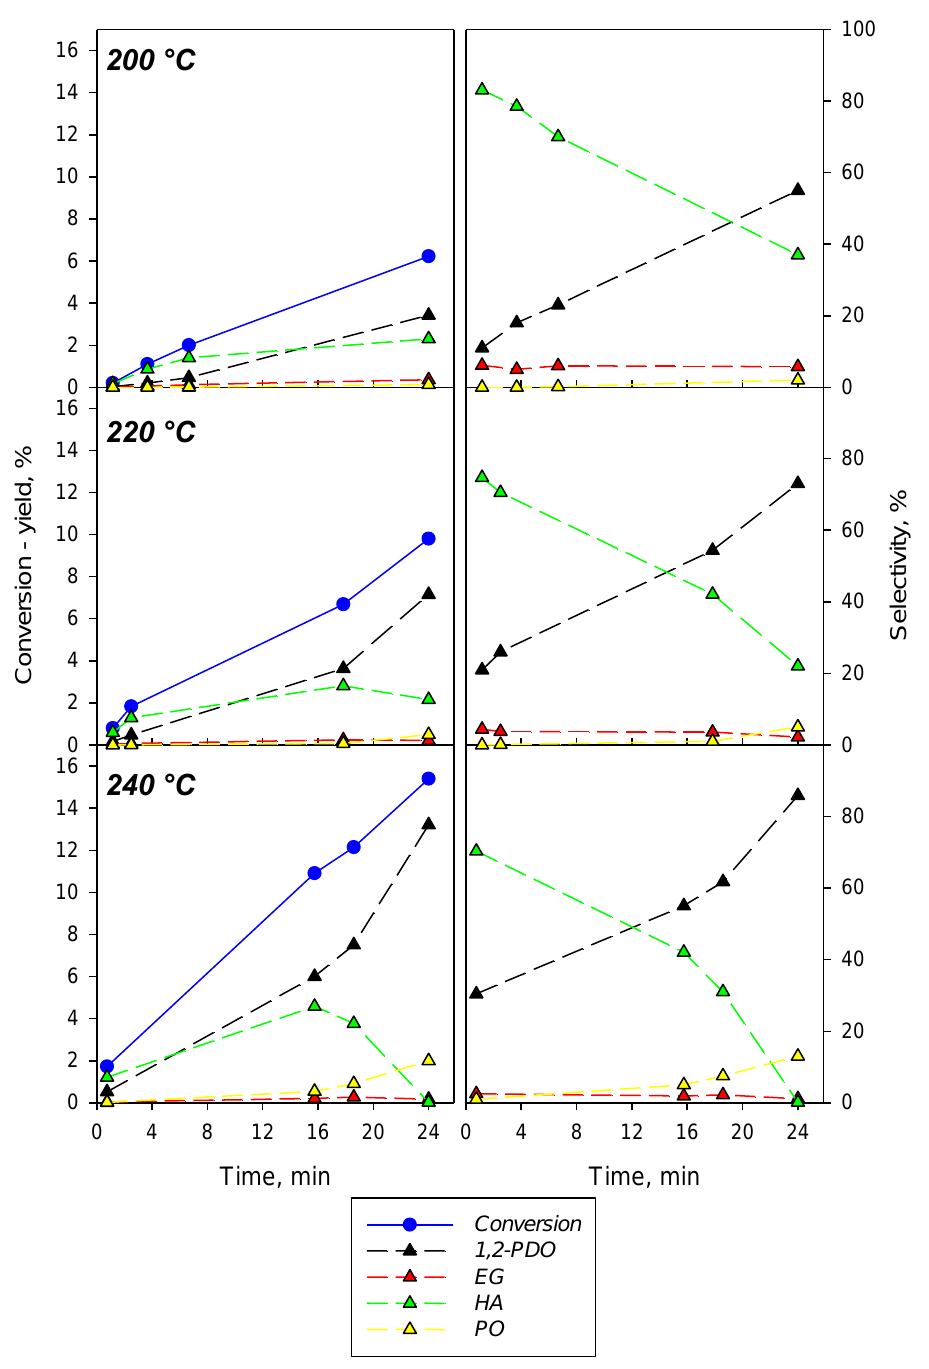
Figure 8. Cu(M)-Zr(C) glycerol conversion, yields, and selectivities to products as a function of the reaction time at different reaction temperatures. Initial P = 20 bar(g); H 2 = 20 vol%; rotation speed = 500 rpm (PDO = 1,2-propanediol, EG = ethylene glycol, HA = hydroxyacetone, PO = 1-propanol).